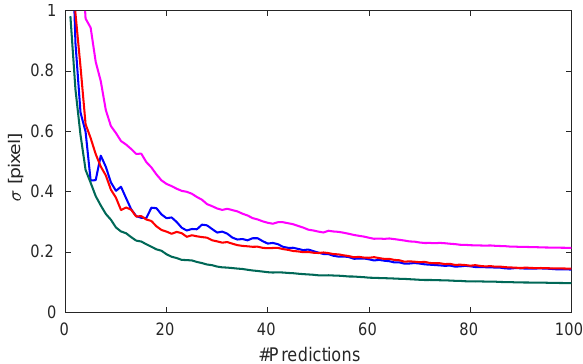
Figure 3: Necessary number of predictions during test